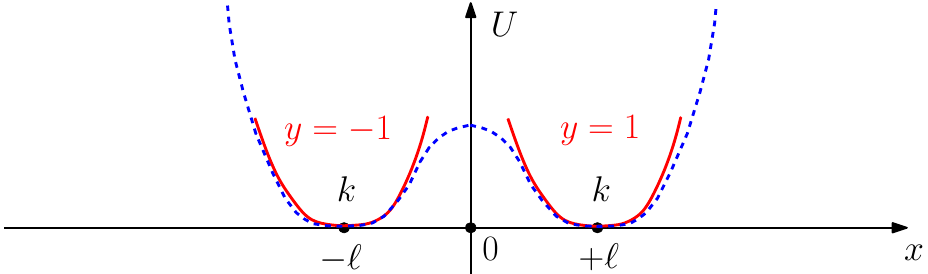
Figure 1. Bistable symmetric potential energy of a single domain (blue dashed line) and its approximation by means of four parabolic profiles (red solid